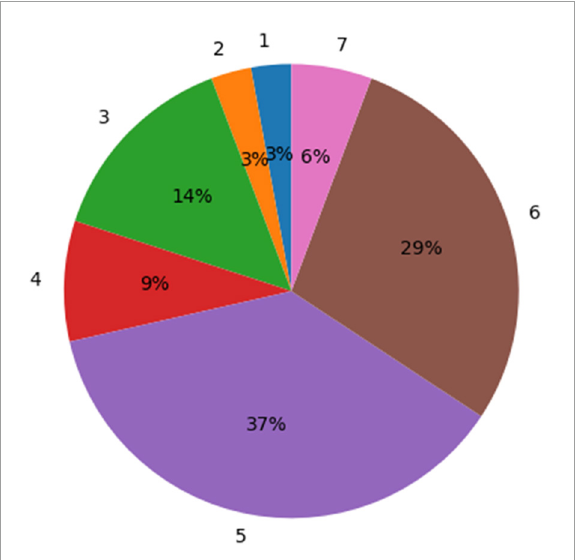
FIGURE4 Glioblastoma multiforme (GBM) tumor as appeared on MR T1 gad images (Left) along with results of five models and the ground truth. The methods segment the resection cavity (green), necrotic core (yellow), and enhancing tissue (orange). Red arrows point to some of the visible errors in the segmentation results. These errors are reduced with our full method. The baseline model fails to distinguish between necrotic core and resection cavity, misconstruing some necrotic core areas as resection. By integrating surgery type, this issue is resolved. By segmenting the cerebrospinal fluid (CSF), some errors in labeling CSF as resection or necrotic core can be avoided. Our full model incorporating the uncertainty and simultaneous co-training of two models further reduces the visible errors.